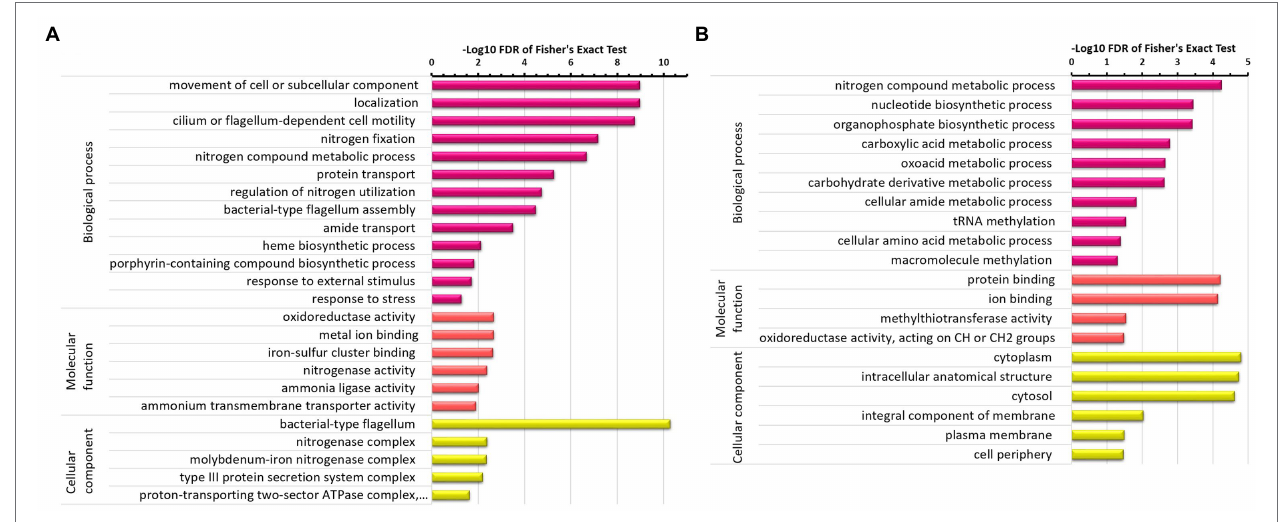
FIGURE 2 | GO terms enrichment analysis of differentially expressed proteins in Z. mobilis under N 2 -fixing condition. (A) GO terms enrichment analysis of upregulated proteins under the N 2 -fixing condition. (B) GO terms enrichment analysis of downregulated proteins under the N 2 -fixing